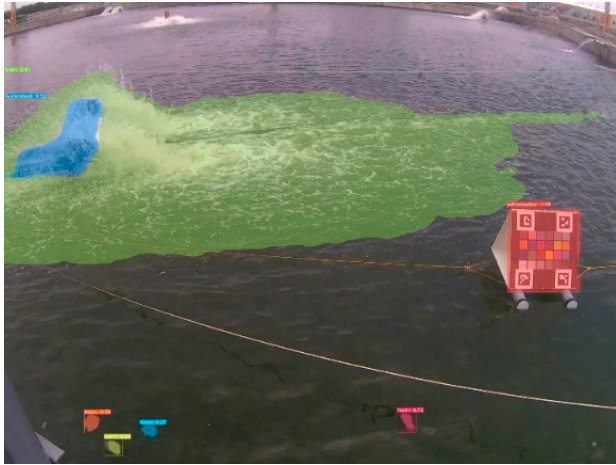
Figure 7. Result of YOLACT-based instance segmentation.